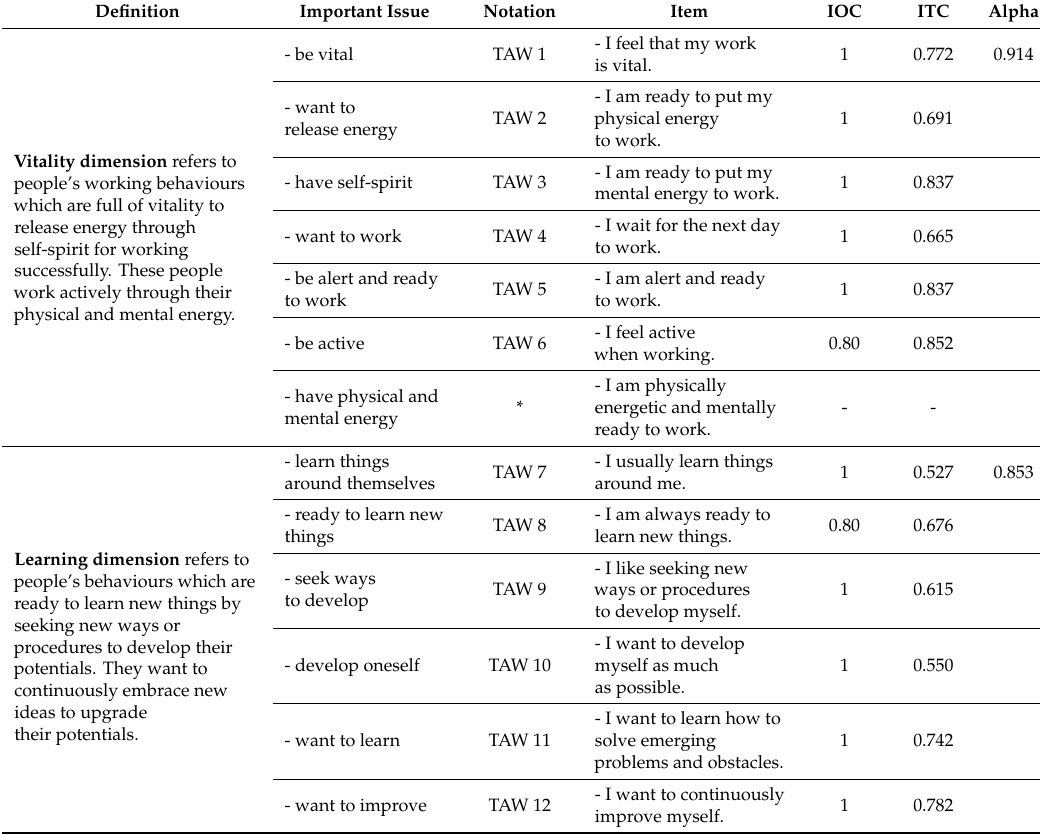
Table 1. Item development and validity and reliability